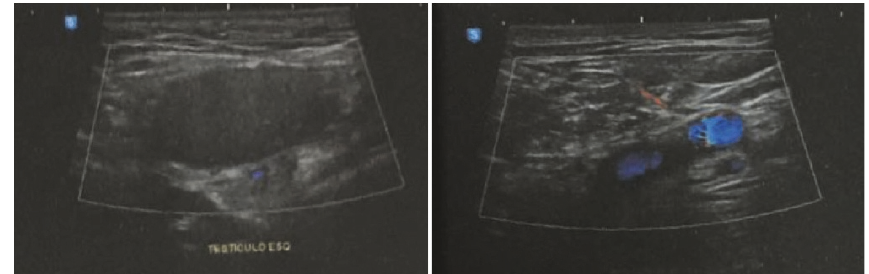
Figure 2: Doppler ultrasound of the left testicle.